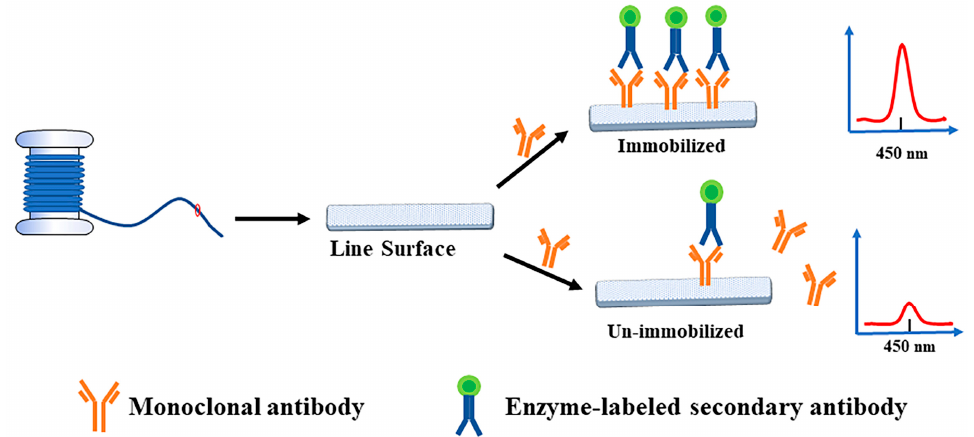
Figure 1. Schematic diagram for screening antibody immobilization materials.